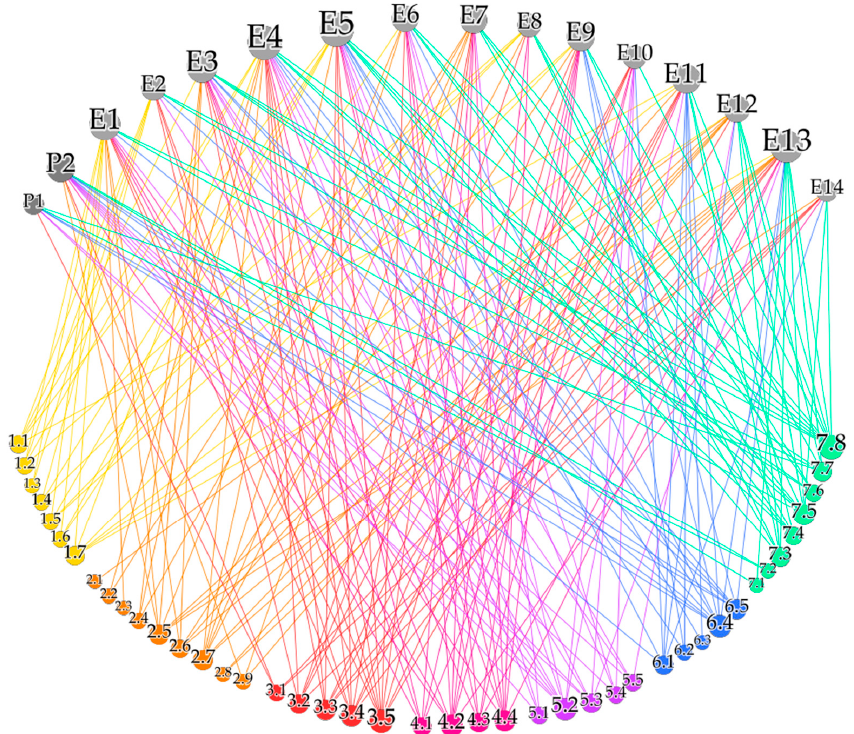
Figure 1. Visualization of the interview network N showing the interviewees (gray nodes at the top) and the codes addressed (colored nodes at the bottom) represented as links.